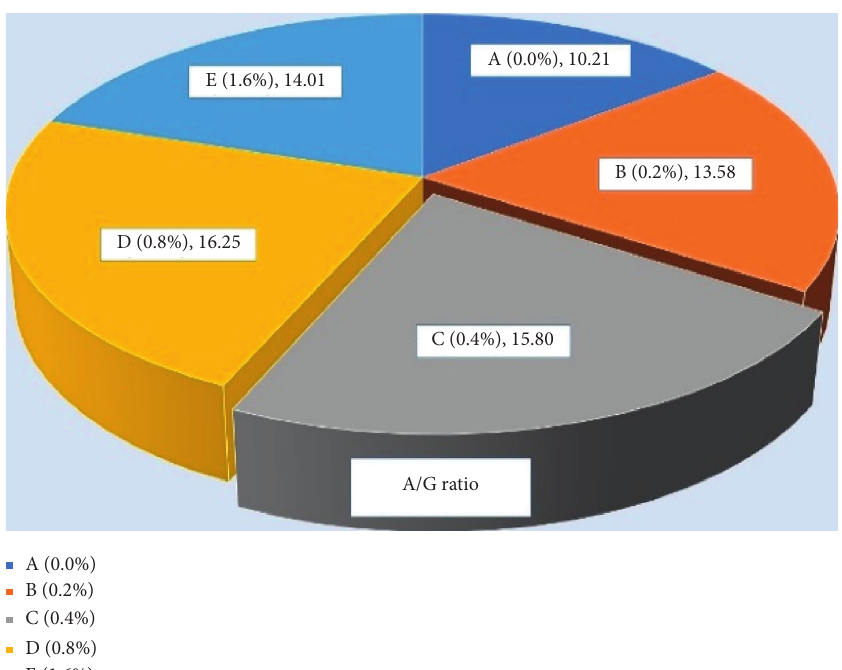
Figure 12: Cyprinus carpio fed varied doses of Aloe vera and ratio of albumin and globulin from liver tissues were studied after 90 days of feeding trial.